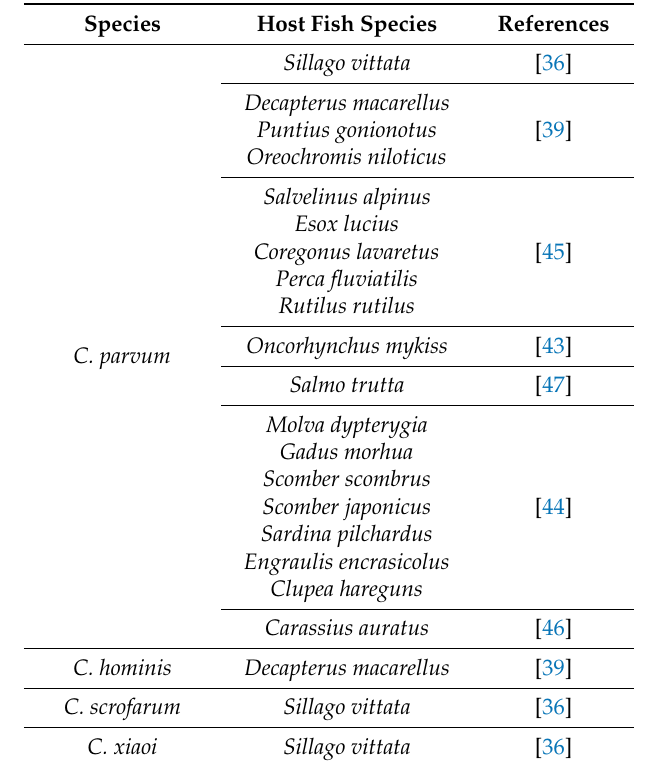
Table 3. Other Cryptosporidium species detected in fish